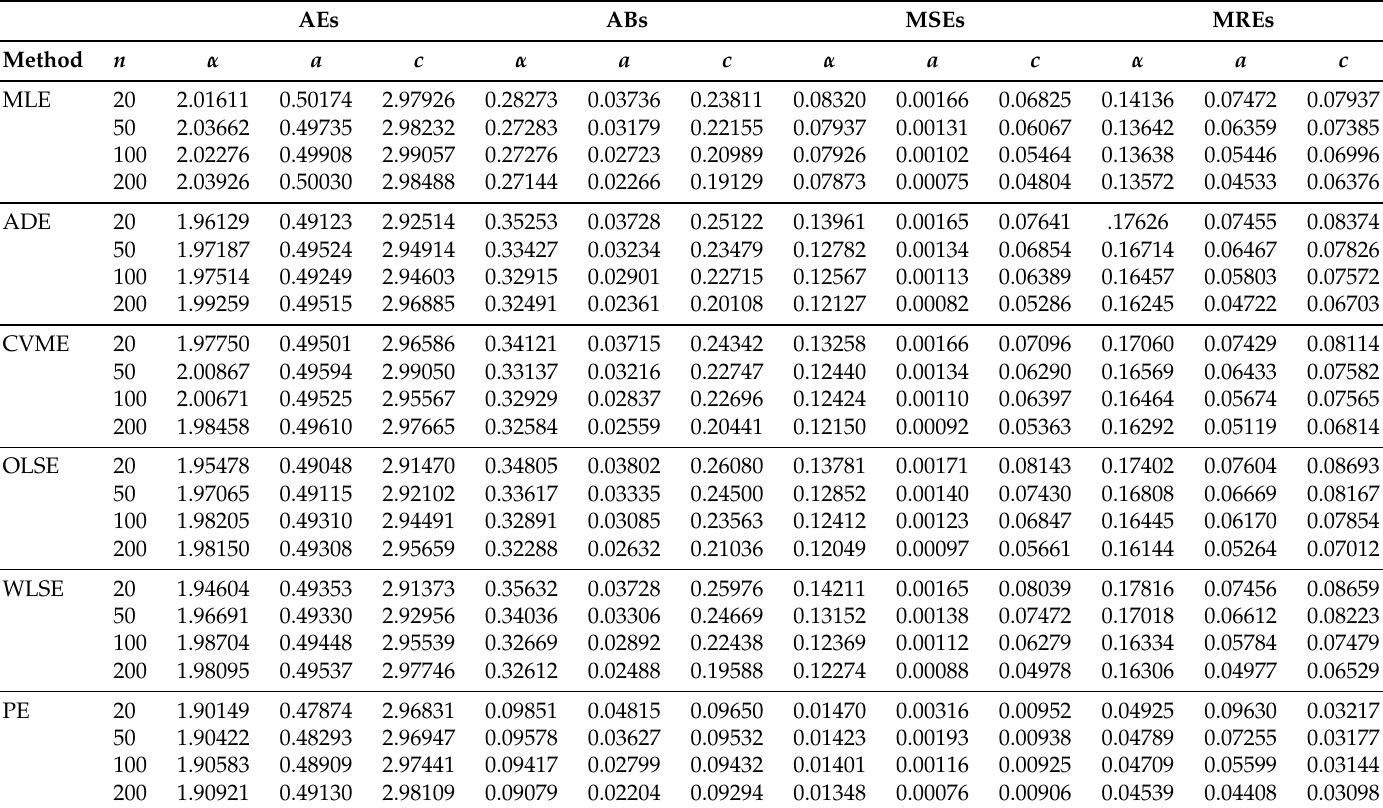
Table A8. The AEs, ABs, MSEs, and MREs for ( α = 2, a = 0.5, c = 3 )